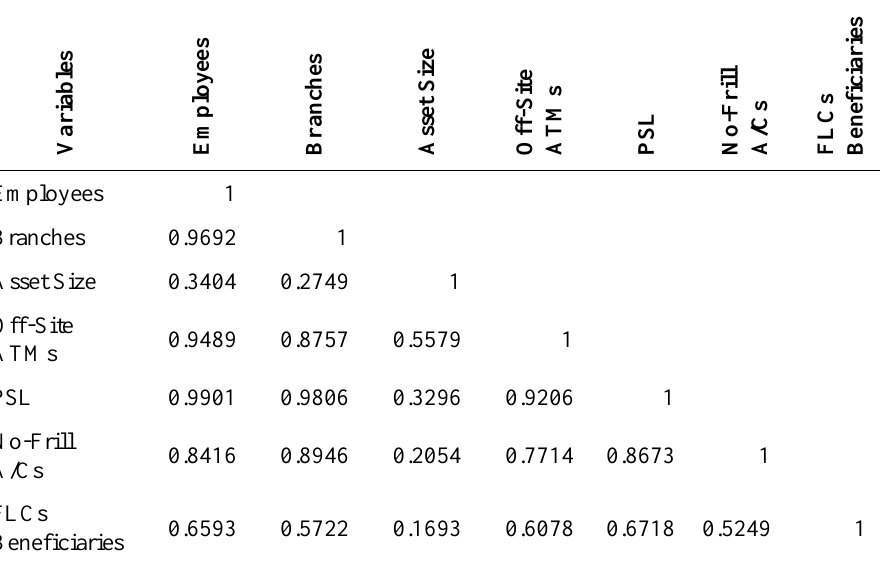
Table 2: Correlation